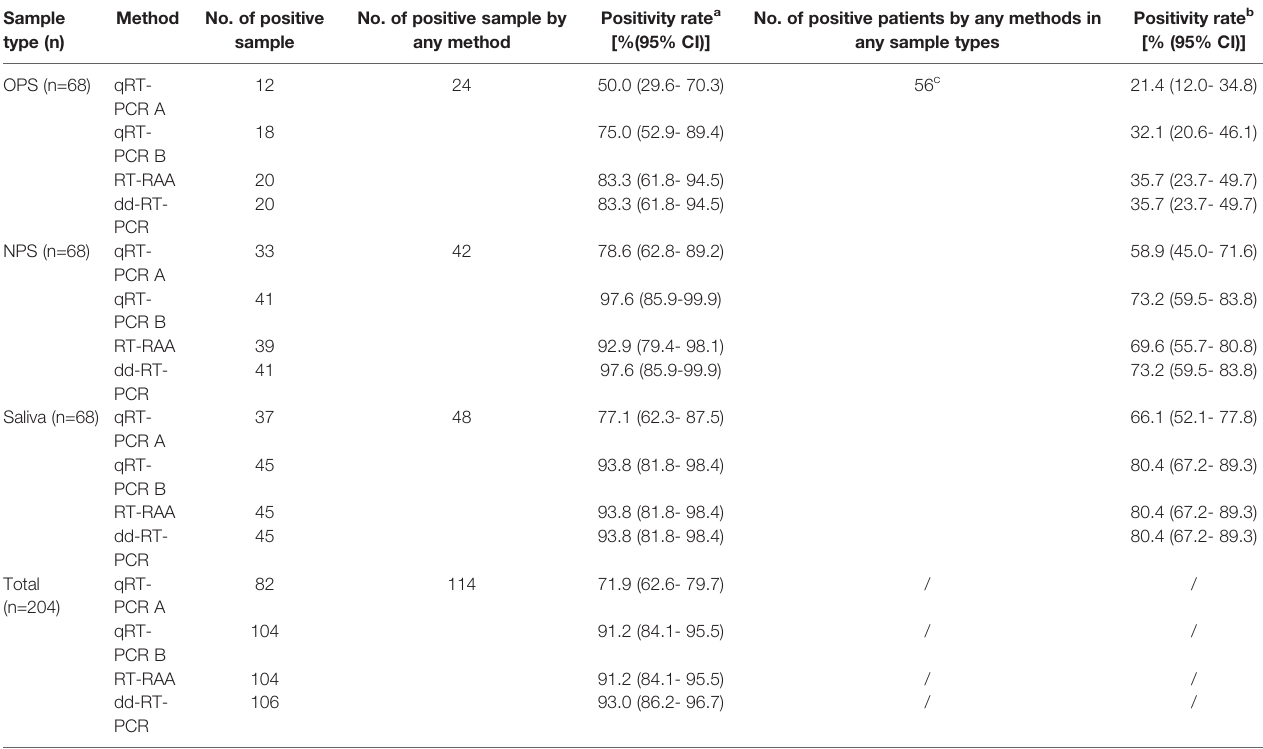
TABLE 4 | Performance of 4 methods in testing 204 samples from 68 patients.